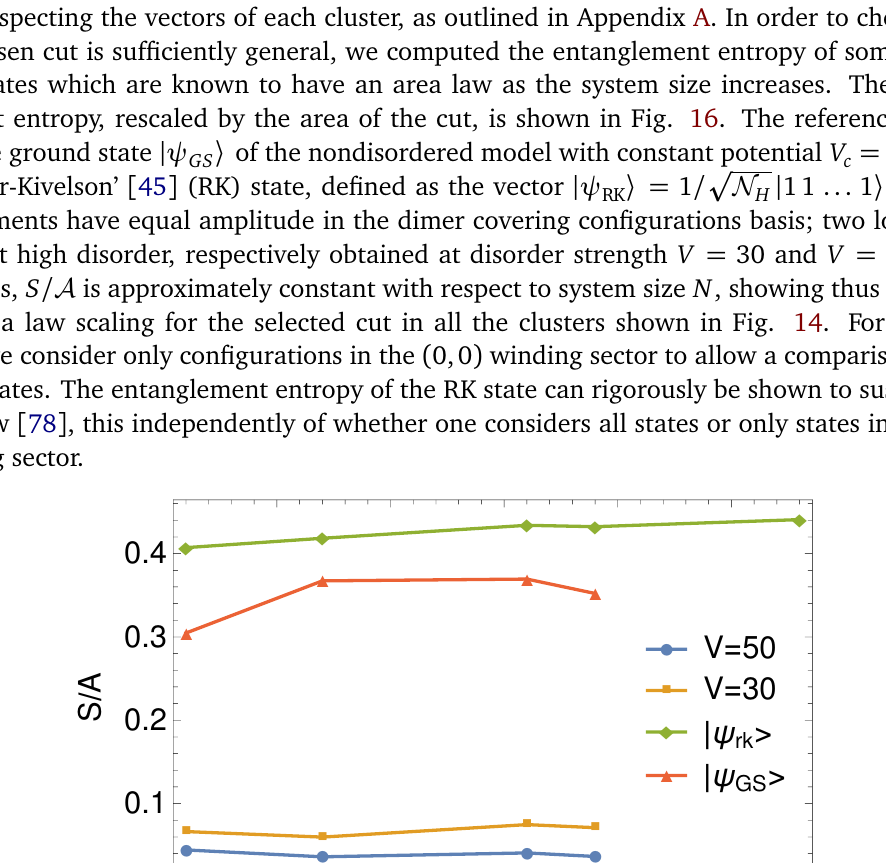
= 0.1, the uniform state c